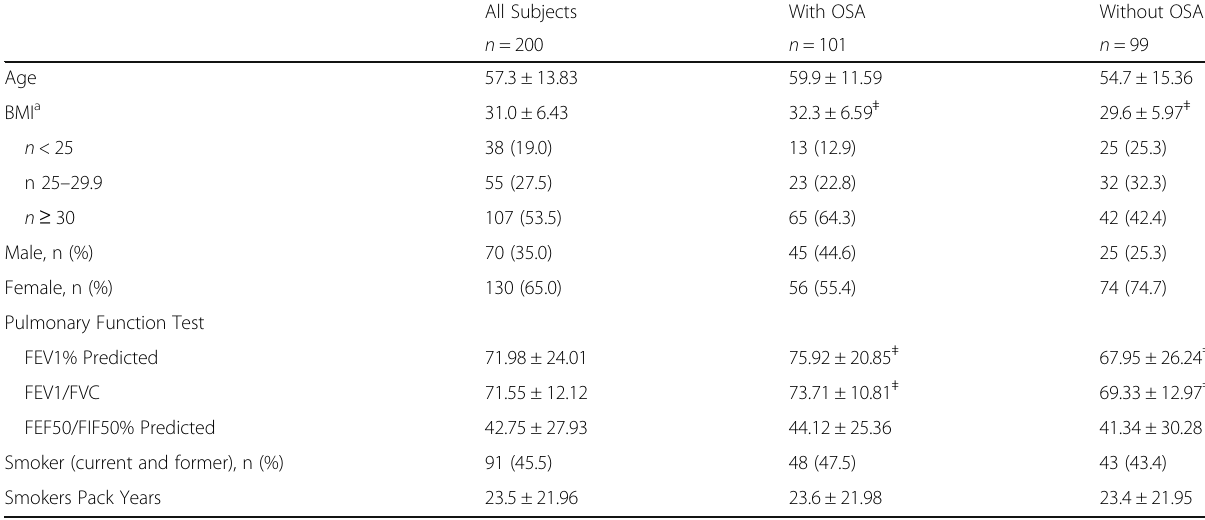
Table 1 Patient